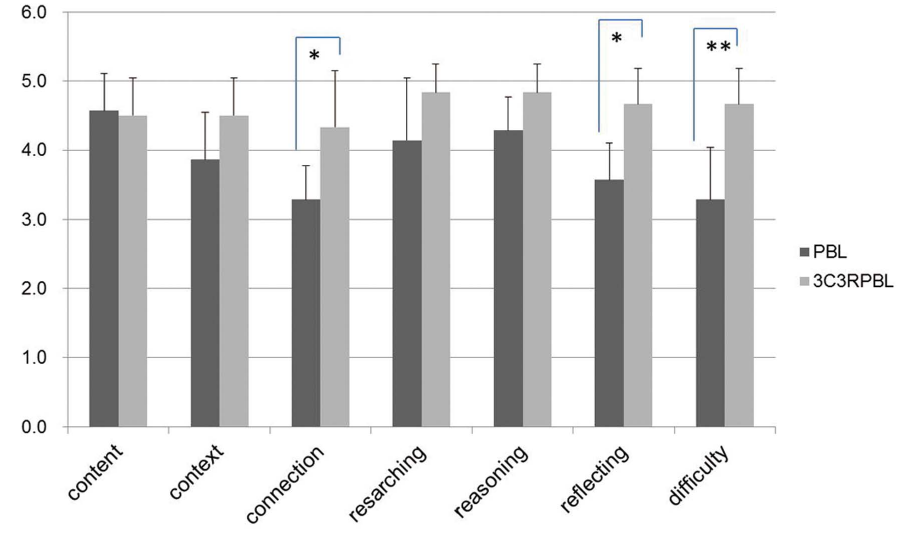
Figure 3. Comparison of test scores from tutors for 3C3R-PBL and PBL.